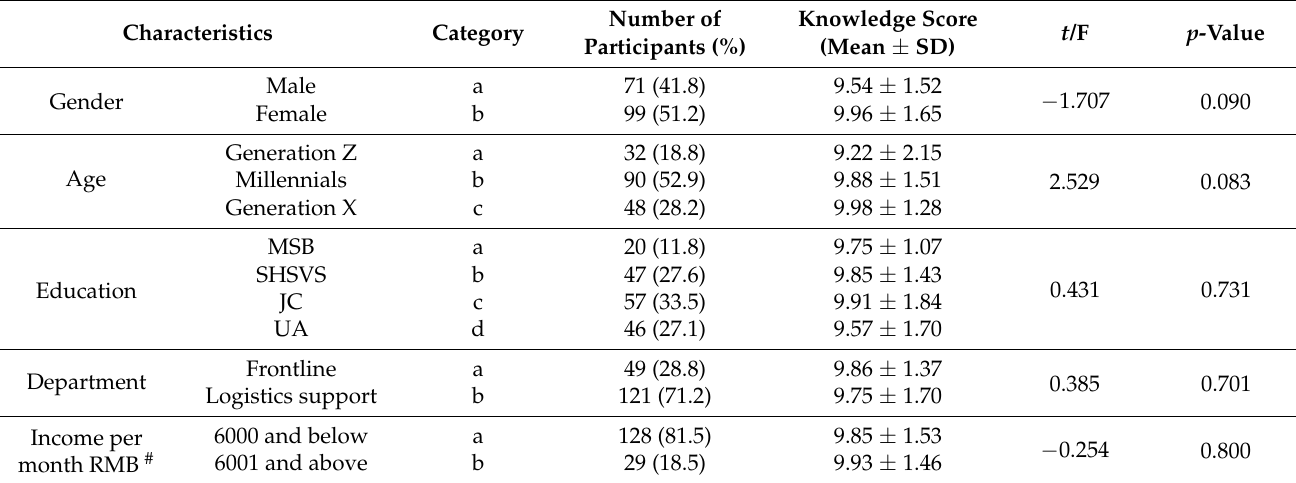
Table 2. Relationship between socio-demographic characteristics of the participants and their knowledge scores about COVID-19 ( n = 170).